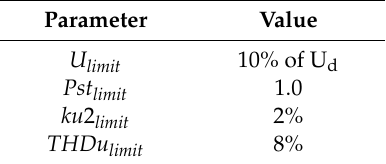
Table 2. Limit values of standard EN 50160 [121] used for the global